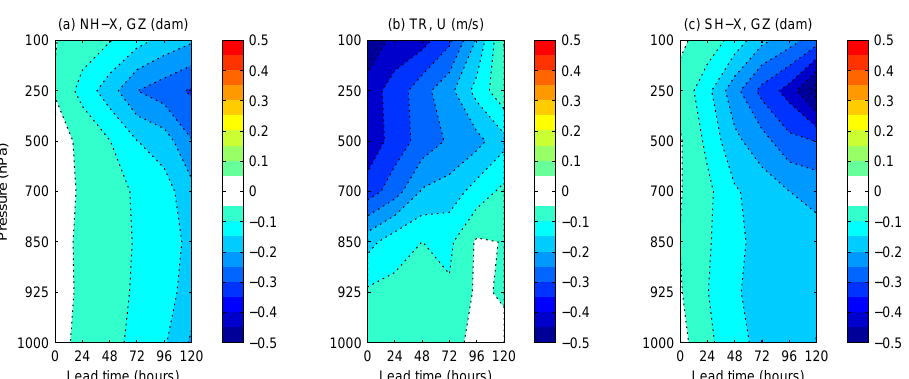
Fig. 5. The difference in standard deviation relative to ERA-Interim reanalyses for the EnVar and 3D-Var forecasts for the Febru- ary/March 2011 period for (a) geopotential height in the northern extra-tropics, (b) zonal wind in the tropics, and (c) geopotential height in the southern extra-tropics. Note that negative values corresponds with a smaller standard deviation relative to ERA-Interim reanalyses (i.e., better quality) for the forecasts from EnVar analyses than for the forecasts from 3D-Var